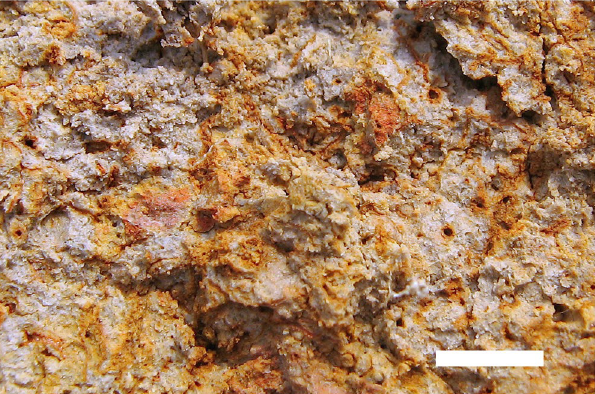
Figure 3. Close-up photograph of the typical soil structure in the subsoil horizons of the Ban Nabone site showing oxidized micro-domains (mostly along cracks and around root channels) in brown-red colours immediately adjacent to reduced micro-domains where greyish colours prevail. The white horizontal bar to the bottom right of the photograph represents 5